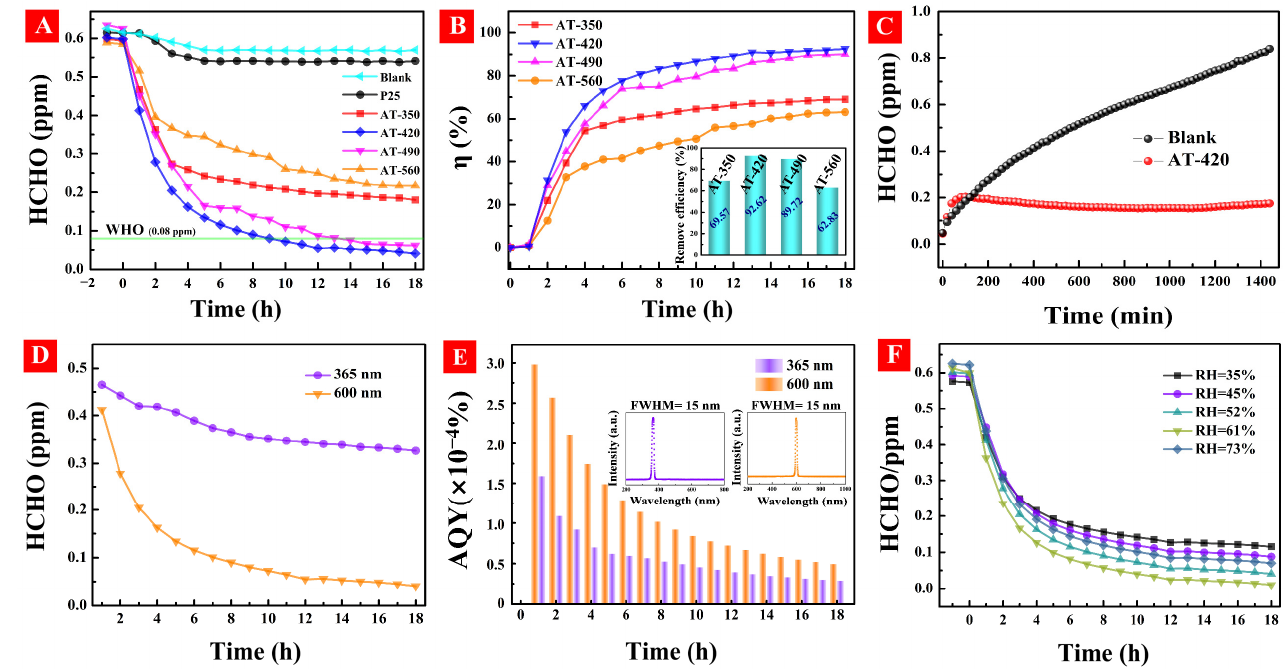
Figure 9. ( A ) Visible-light formaldehyde photodegradation and ( B ) the conversion efficiency with different samples, and the inset was the remove efficiency for all samples. ( C ) Durable test of AT-420 under simulated indoor conditions. ( D ) The HCHO photodegradations under 365-nm and 600-nm light sources using AT-420 sample. ( E ) The AQY of formaldehyde photodegradation with different wavelength light using AT-420 coating, and the inset were the spectra of UV (365 nm, FWHM = 15 nm) and visible (600 nm, FWHM = 15 nm) light. ( F ) The effect of relative humidity for AT-420 coating using 600-nm light